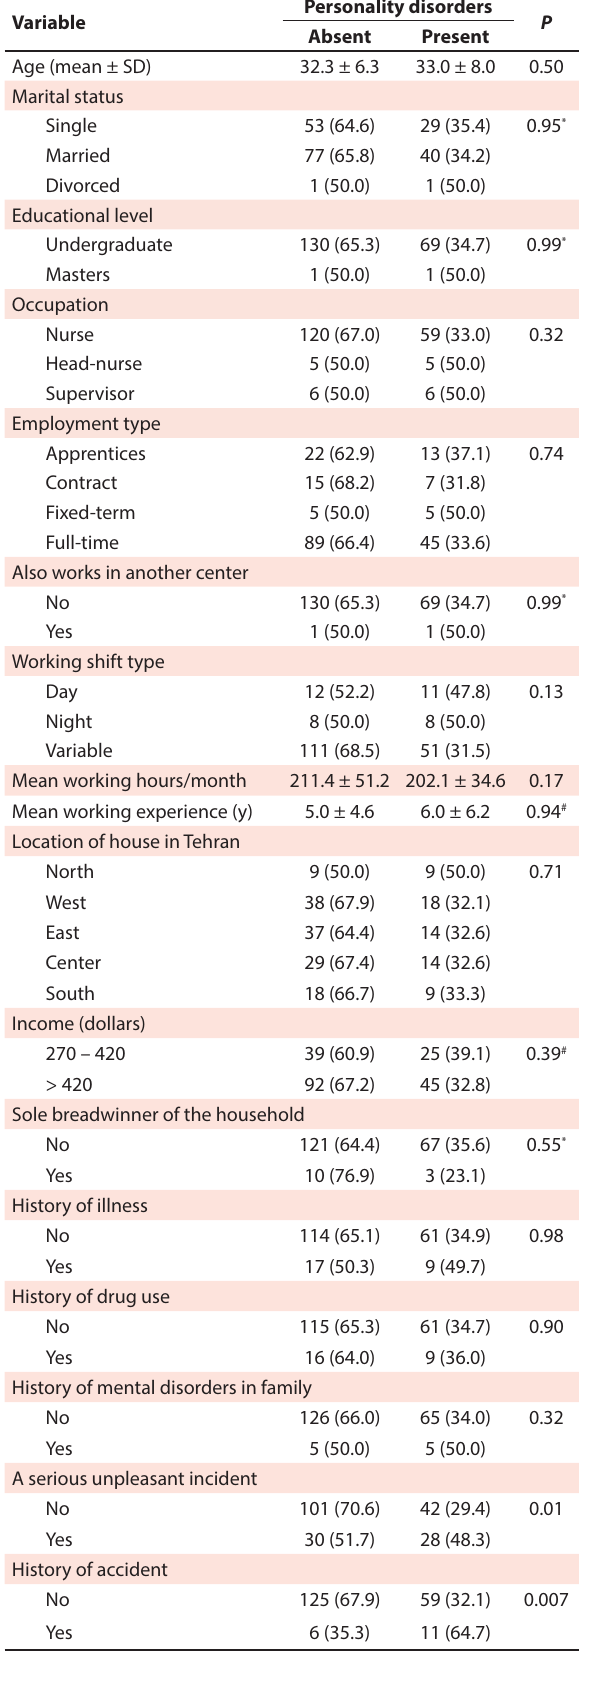
Table 1. The relationship of demographic and baseline factors of the studied population with personality disorders Variable